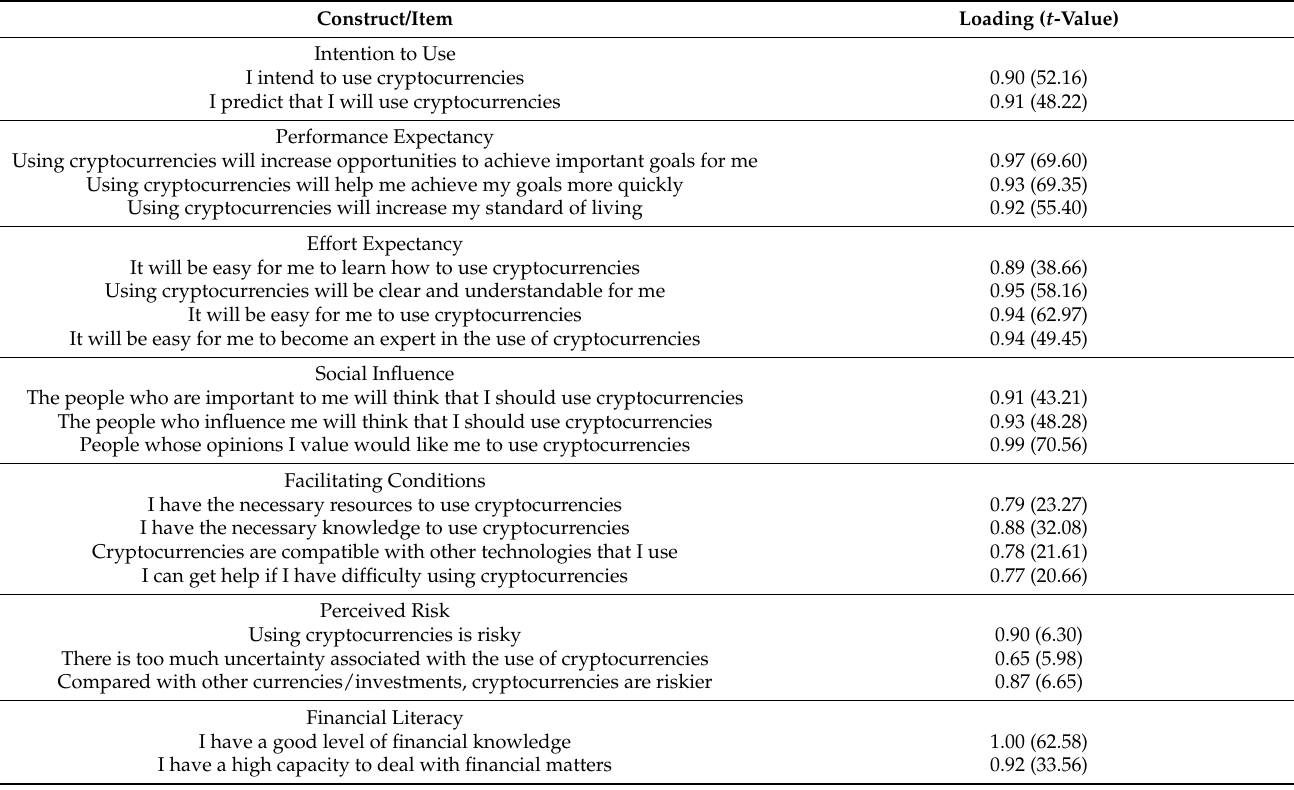
Table A2. Standarized loadings and t -values.